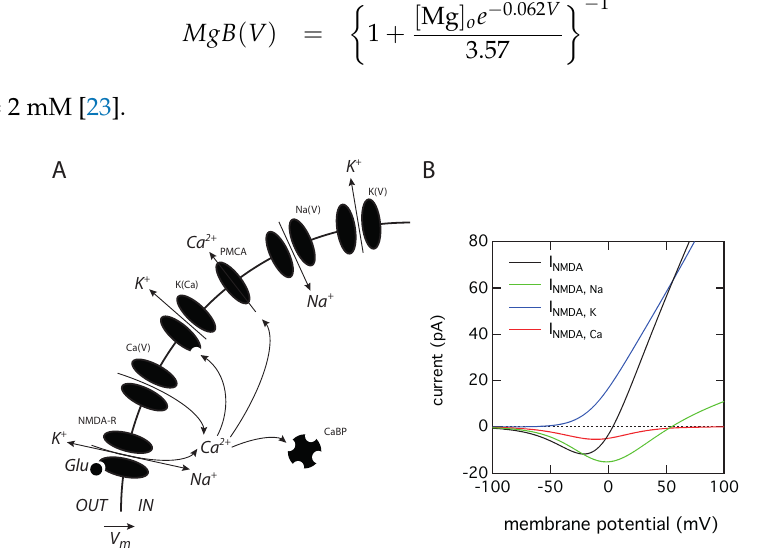
Figure 1. Model of neuronal activity including a tonically active NMDA-R current. ( A ) Schematic representation showing the various ligand- and voltage-gated channels used in the model: N-methyl-D-aspartate receptor ( NMDA − R ), high-voltage-gated calcium channels (Ca ( V ) ), calcium-activated potassium channels (K(Ca)), plasma membrane calcium ATPase ( PMCA ), voltage-dependent sodium channels (Na(V)), and delayed rectifier potassium channels (K(V)). The model also takes into account intracellular calcium buffers ( CaBP ). ( B ) Current-voltage relationship for the three different ionic components ( I NMDA ,Na , I NMDA ,K , and I NMDA ,Ca ) and the total current ( I NMDA ) flowing through the tonically activated NMDA